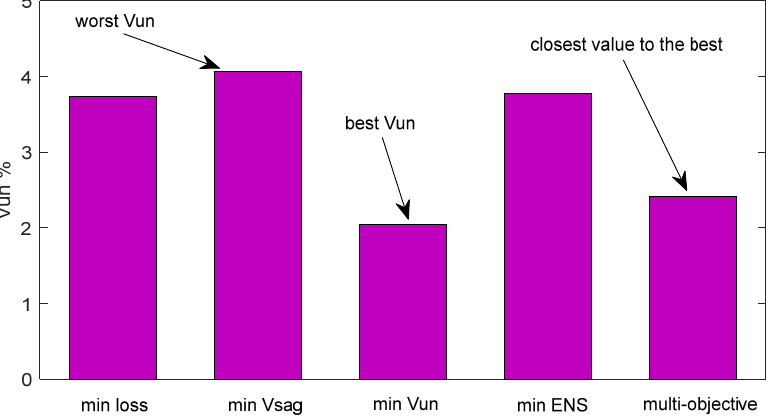
Figure 7. The voltage sag in single-criterion and many-criteria optimizations using AEFAPS.